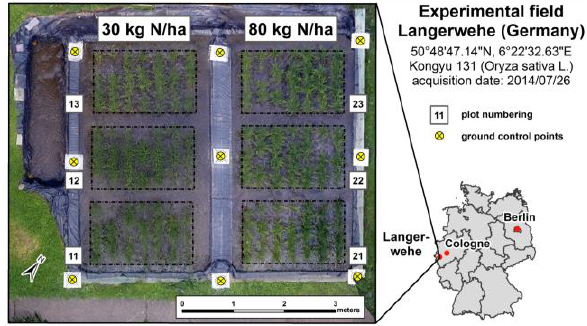
Figure 1: Location and structure of the experiment field